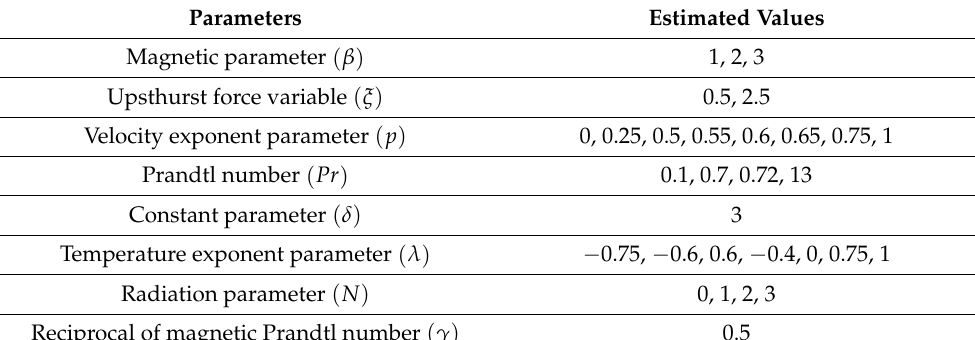
Table 1. Estimated values in present study.